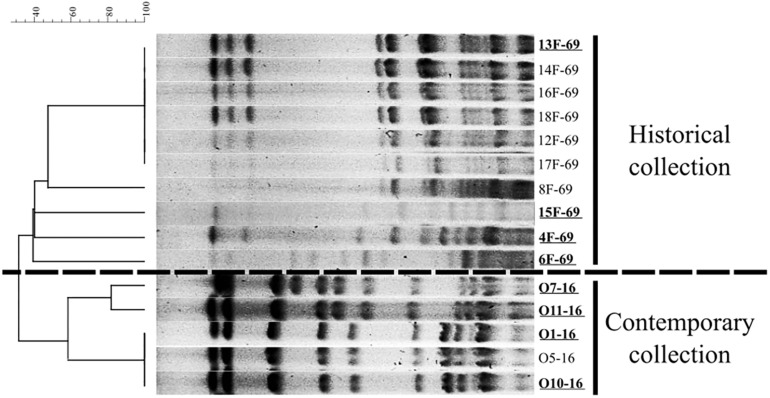
Dendrogram based on Dice’s coefficient showing the representative pulse-field gel electrophoresis (PFGE) pattern of the historical (10 out of 21 isolates) and the contemporary Serratia marcescens collections studied.